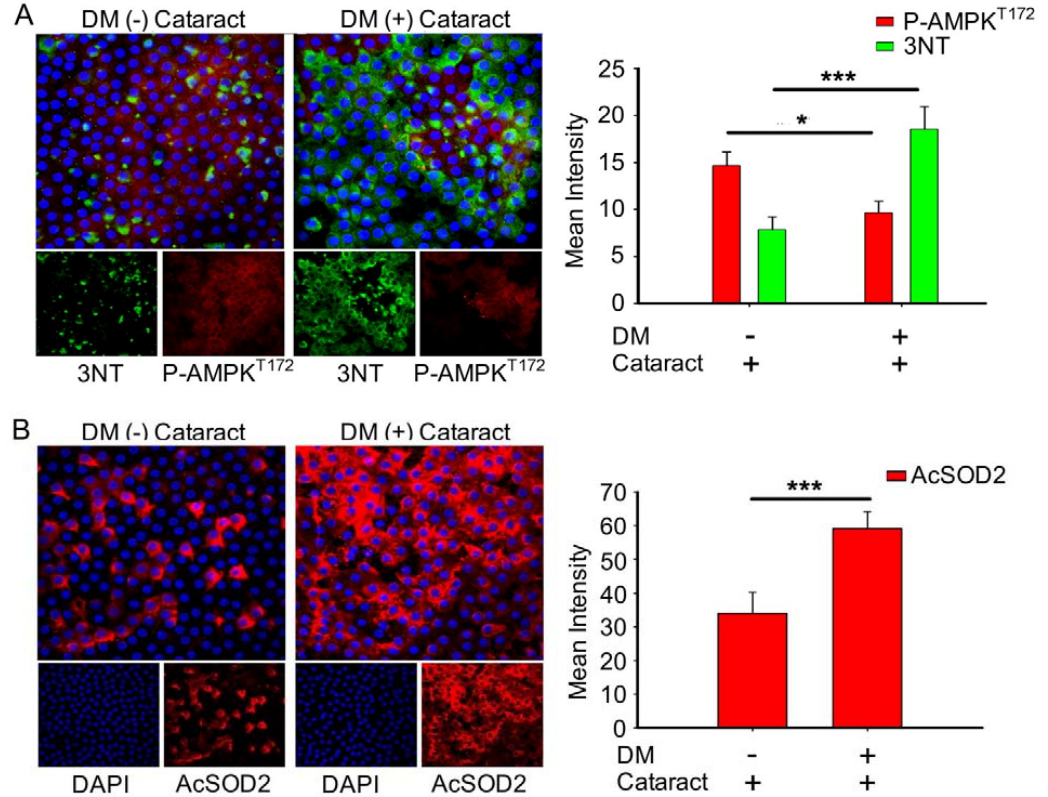
Figure 3. DM ( + ) cataract patients had increased energy imbalance, increased reactive oxygen species (ROS) products, and lower superoxide dismutase 2 SOD2 activity than DM ( − ) cataract patients. ( A ) Representative photomicrographs of p-AMPK T172 (red) and 3-nitrotyrosine (3NT, green), and ( B ) of acetyl SOD2 (AcSOD2, red). DAPI (blue) was used to label cell nuclei. Values are presented as means ± SEMs ( n = 10 per group, separate experimental groups in each figure). * p < 0.05 and *** p < 0.001.